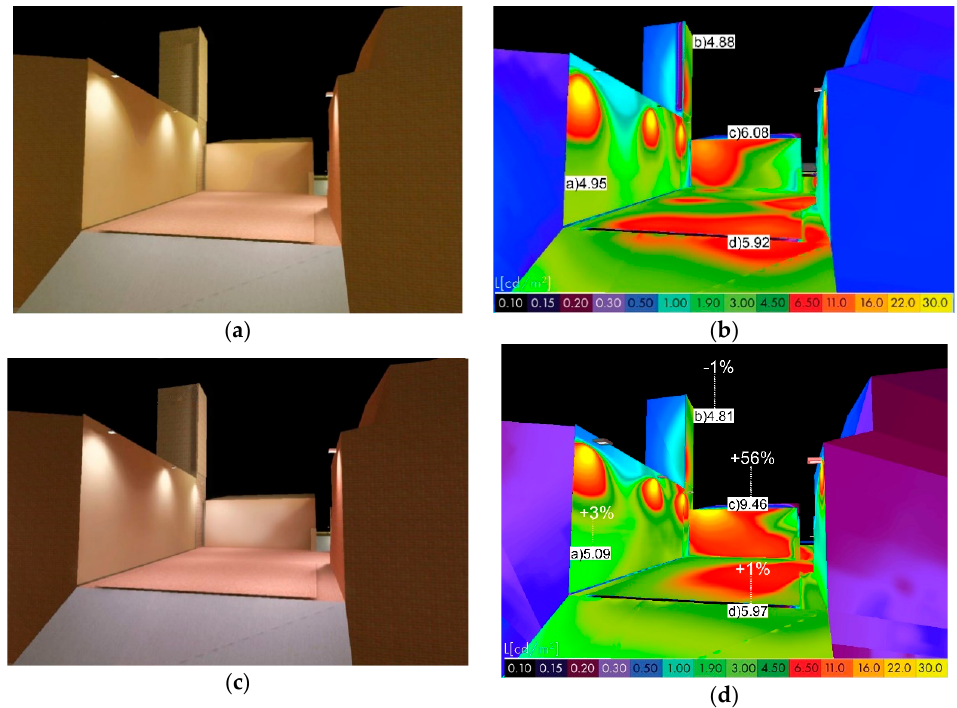
Figure 12. Observation point I1 (simulation performed using Dialux EVO software): ( a ) render of the ex-ante condition; ( b ) false colour render of the ex-ante luminance distribution. In evidence the analysed vertical surfaces and the corre- sponding average luminance values; ( c ) render of the ex-post condition; ( d ) false colour render of the ex-post luminance distribution. In evidence the analysed vertical surfaces, the corresponding average luminance values and the Relative Differences (RD) between the average luminance of the ex-ante and the ex-post installations. Table 19. Observation point I1: (a) Cassero Façade, (b) Cassero tower, (c) residential building, (d) horizontal floor.